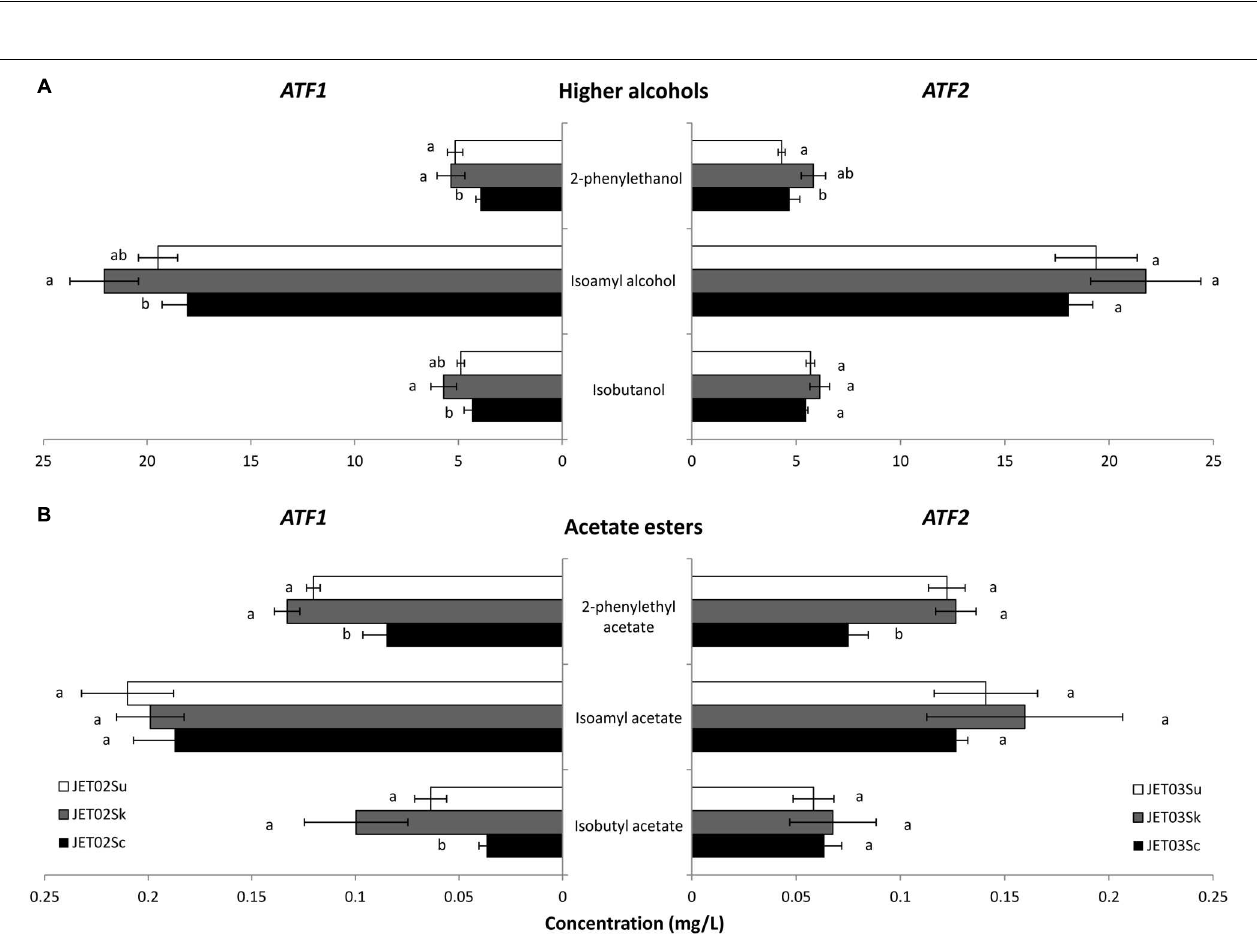
FIGURE 2 | Production of higher alcohols (A) and acetate esters (B) by the JET02-derived strains that harbored the individual ATF1 orthologs (left-oriented bars) and by the JET03-derived strains that harbored the individual ATF2 orthologs (right-oriented bars) during synthetic wine must fermentation. The statistically significant differences among the strains were determined independently for each compound and are indicated by labels beside the columns.